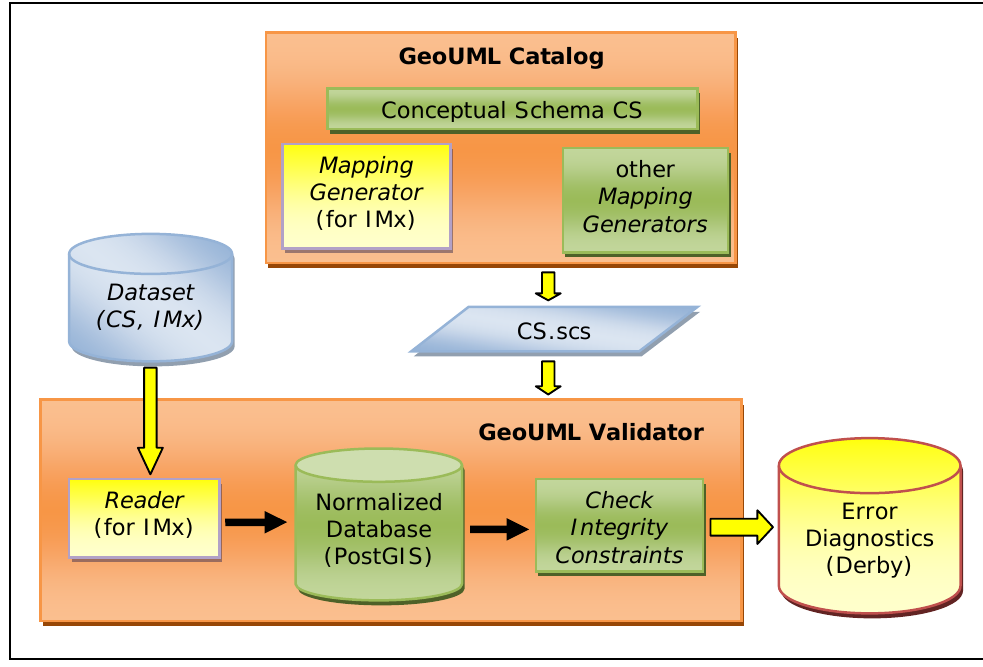
Figure 1. Validation of a Dataset with Conceptual Schema SC and Implementation Model